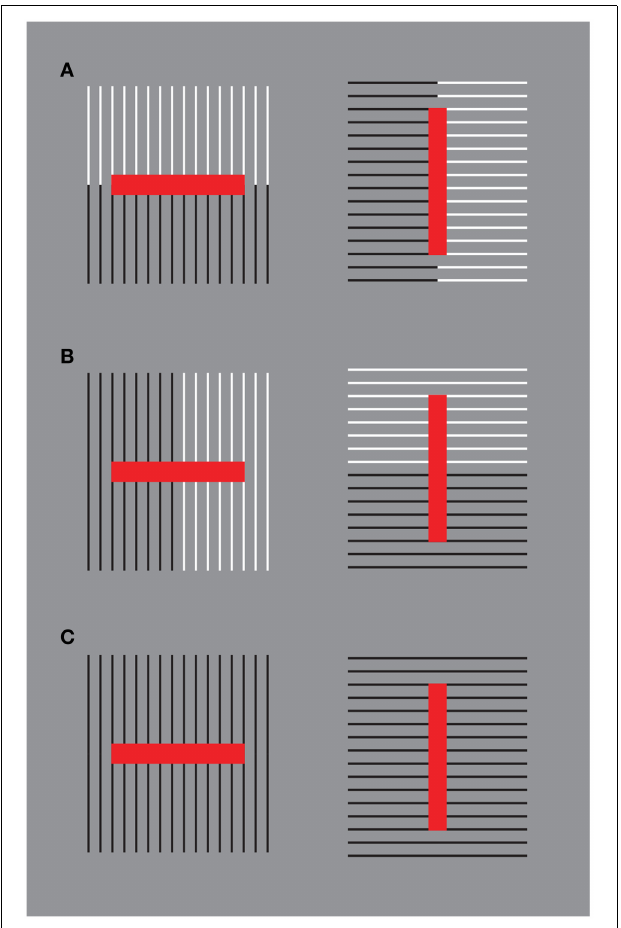
FIGURE 16 | By introducing other sources of directional organization the size effects can be further enhanced or weakened. For further details please see the